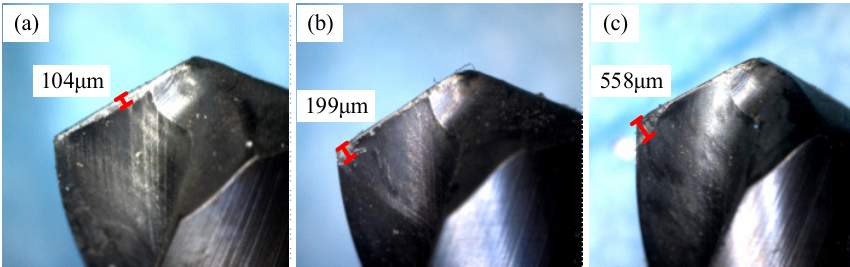
Figure 7. Experimental set-up. Table 1. Geometric parameters of drill bit.